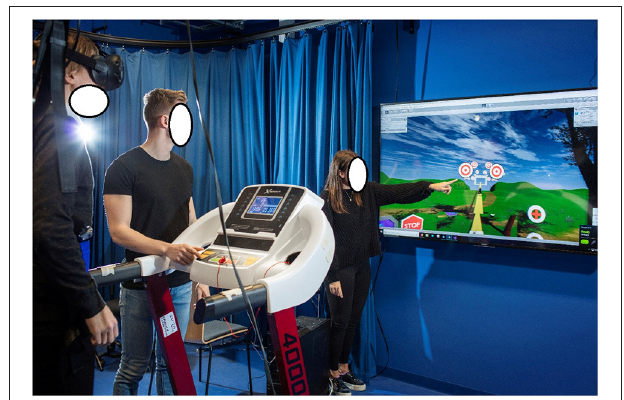
FIGURE 1 | VR-mill game setup. The player is wearing an HMD and a safety harness while walking on the treadmill. Clinicians or assistants can see a 2D image of the scene and the player’s actions on the screen in front of the